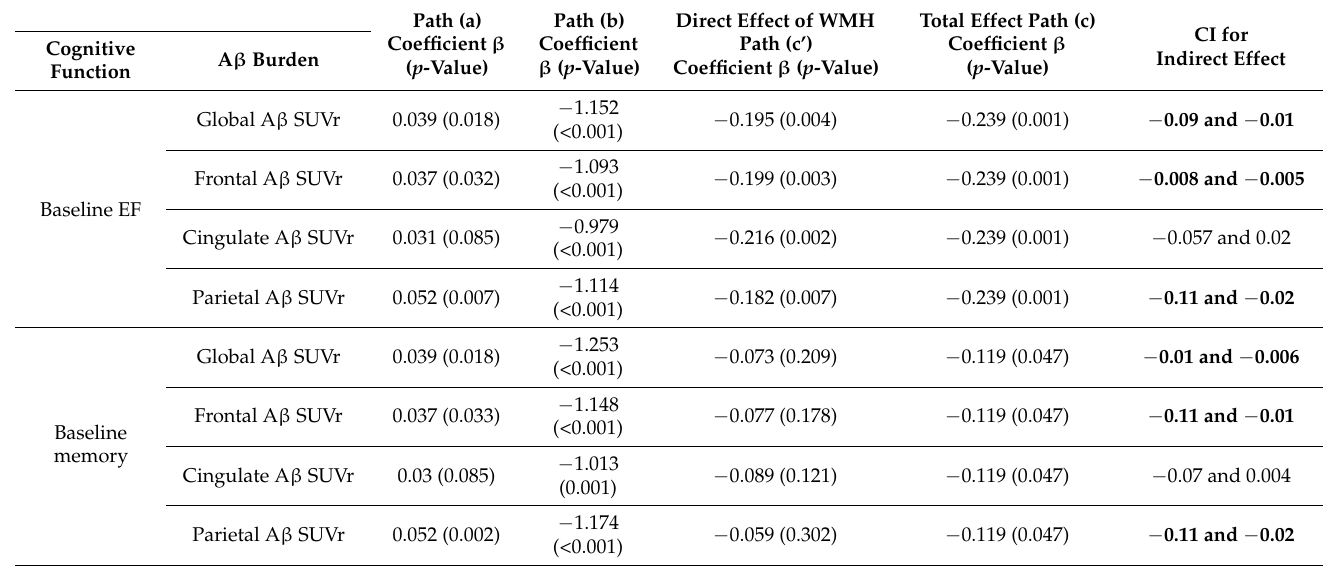
The mediation effects of global and regional A β burden on WMH-related cognitive